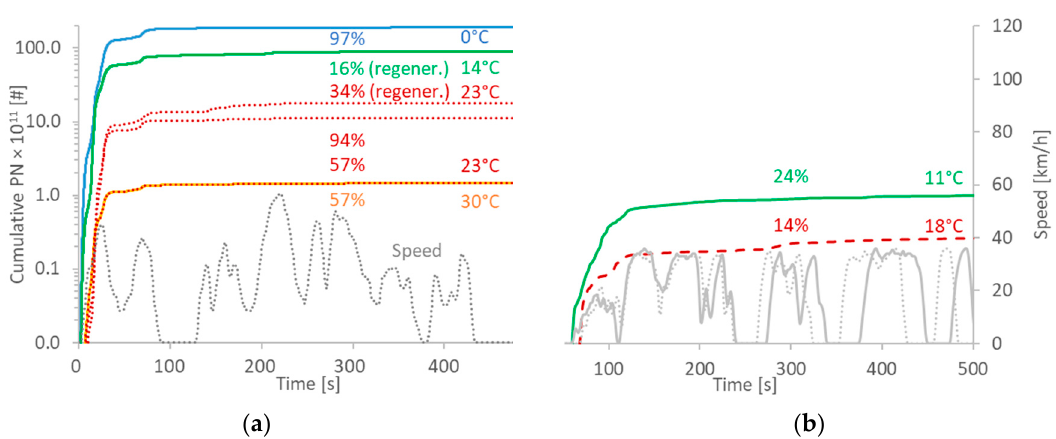
Figure 9. Cumulative Particle Number (PN) emissions ( > 23 nm) at various ambient temperatures: ( a ) laboratory WLTCs; ( b ) on-road Traffic routes. Percentages give the ratio of cumulative PN after 300 s to the total PN at the end of the test. In brackets is mentioned if a regeneration event took place at the high speed part of the cycle. WLTC = Worldwide Light-duty Test Cycle.